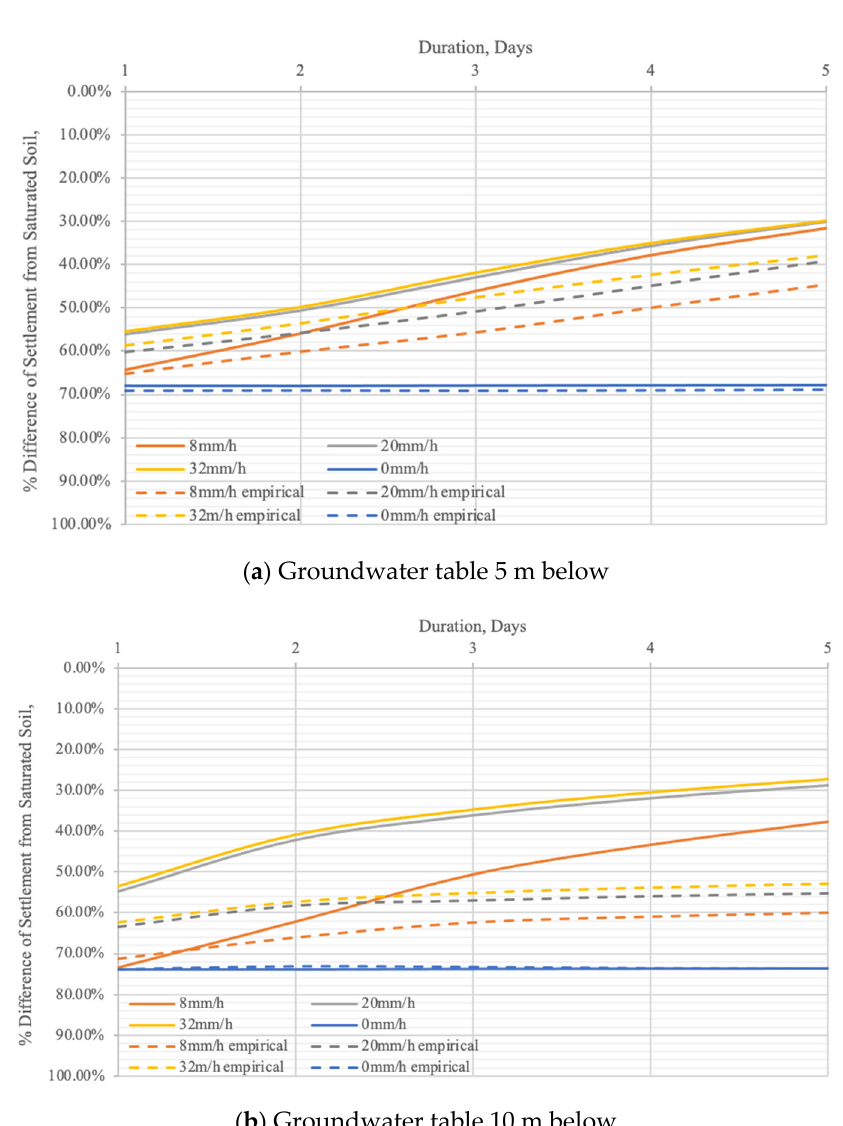
Figure 10. Comparison of time–settlement curves between FE and calculated results.